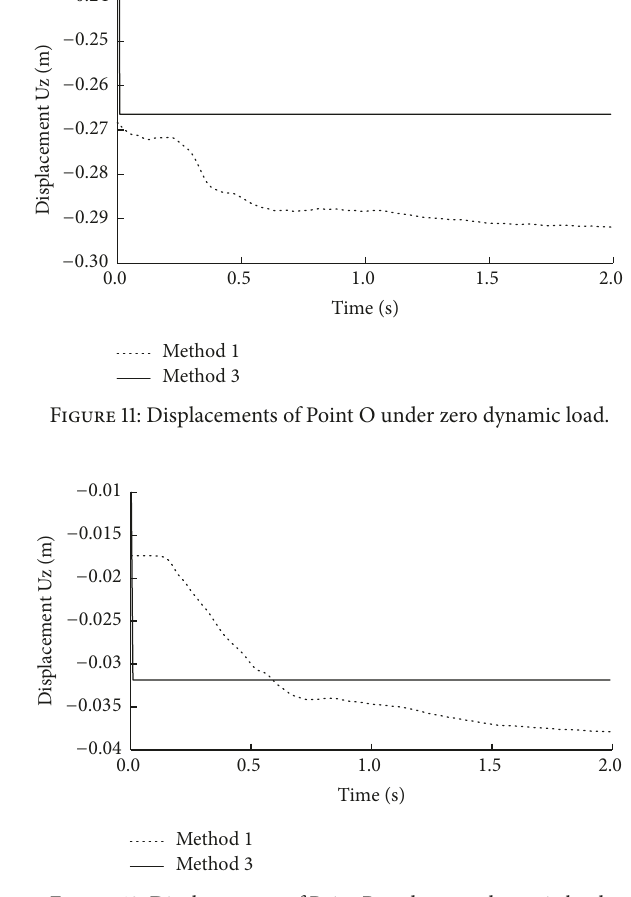
artificial boundary is feasible and suitable for static-dynamic synthetical analysis. The complicated process of importing the initial stress field and applying node constraint reaction force is avoided.